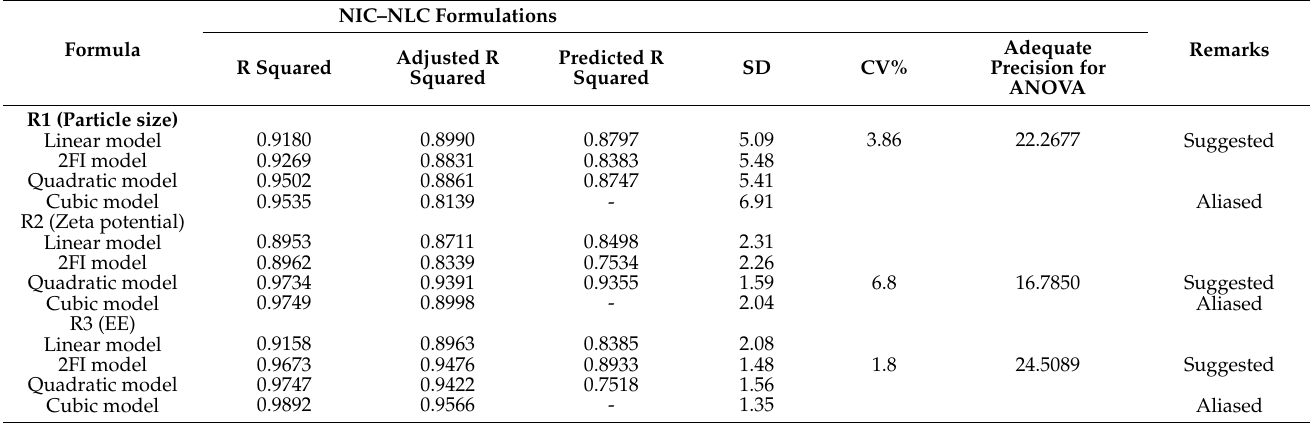
Table 3. Regression analysis results and ANOVA for different response surface models.